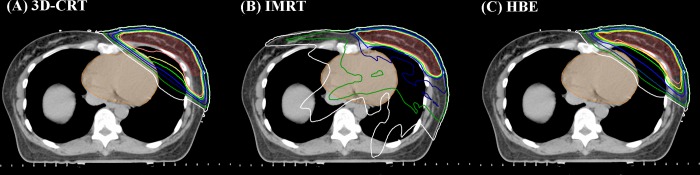
Dose distributions of (A) the 3D-CRT, (B) IMRT and (C) HBE plans (PTV = semi-lucent red area; heart = semi-lucent orange area; pink line = 49 Gy; yellow line = 47.5 Gy; yellowish green line = 45 Gy; blue line = 40 Gy; navy line = 25 Gy; green line = 10 Gy; white line = 5 Gy). (Abbreviation: 3D-CRT = three-dimensional conformal radiotherapy; HBE = heart block with electron compensation radiotherapy; IMRT = intensity-modulated radiotherapy; PTV = planning target volume).